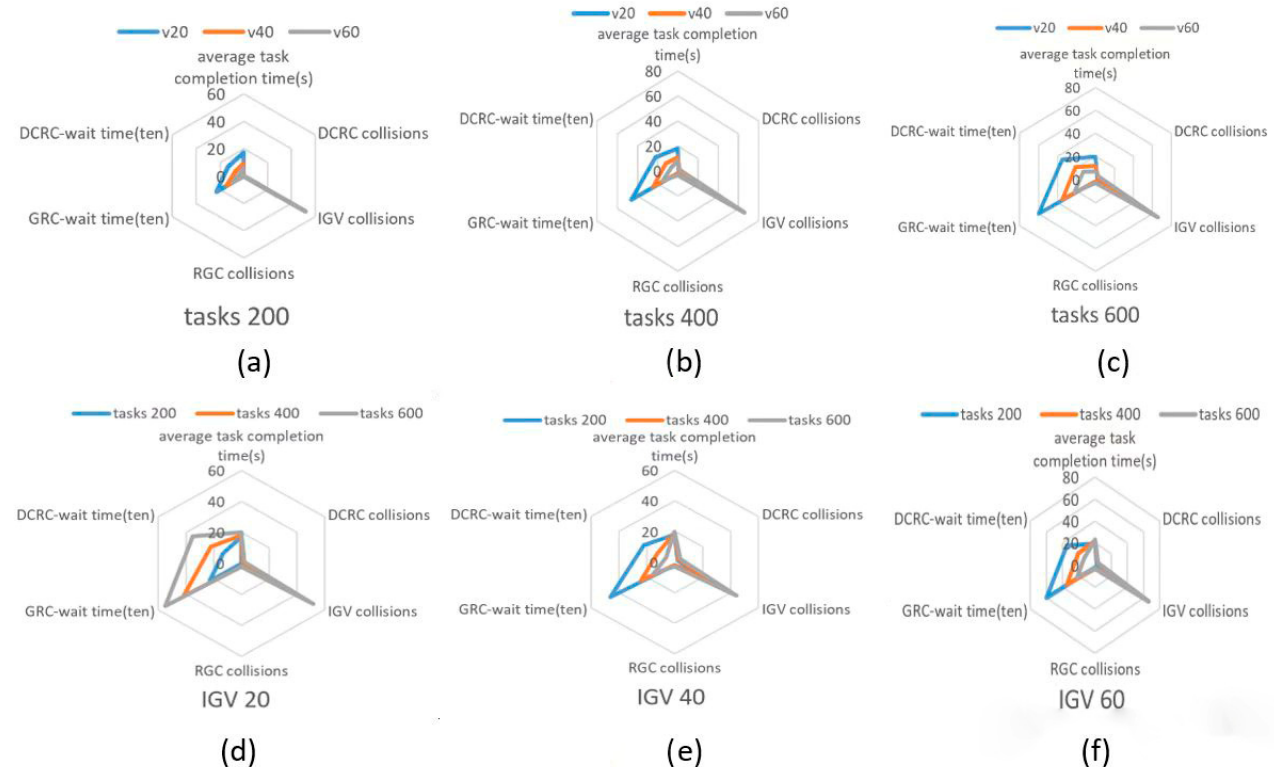
Figure 10. Results of sensitivity analysis for the number of tasks and the number of